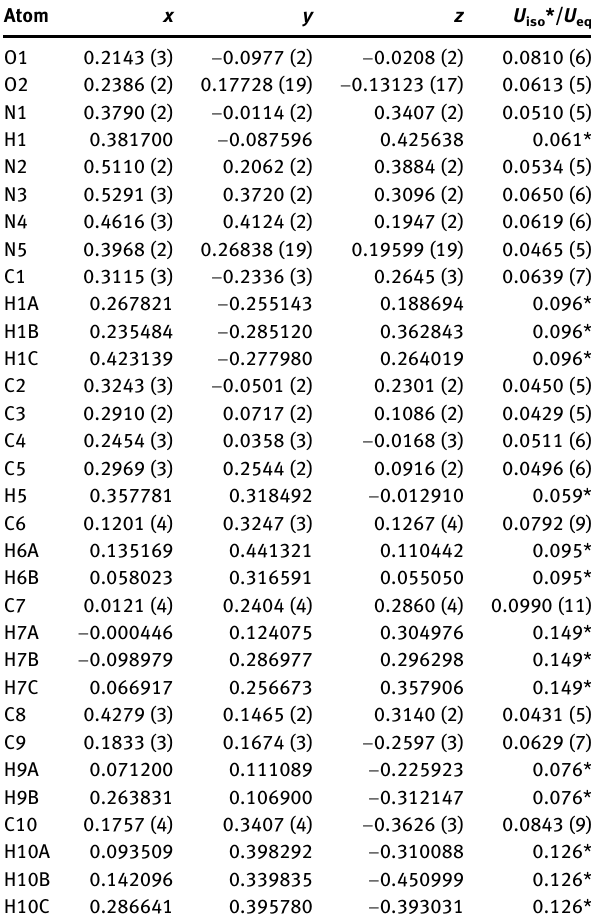
Table  : Fractional atomic coordinates and isotropic or equivalent isotropic displacement parameters (Å 